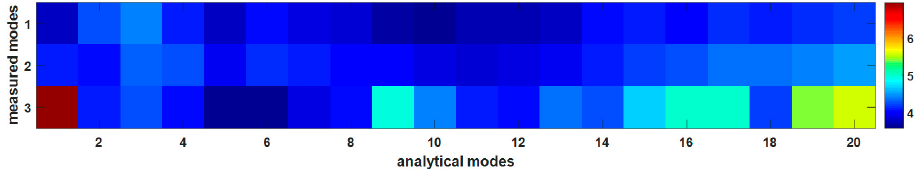
Figure 11. Sensitivity index of damage case C versus MCs 𝑁 𝑖 = 20 and 𝑁 𝑗 = 3 , at a 3% level of noise.